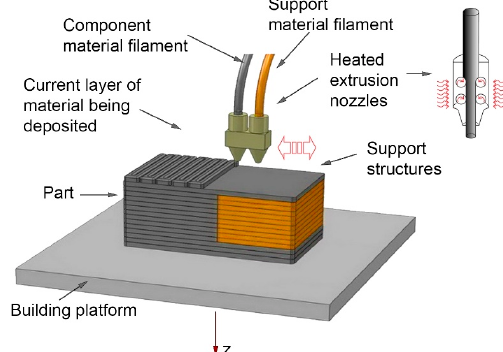
Figure 1. Fused filament fabrication process. Table 1. A summary of some studies on FFF with chopped fibres.